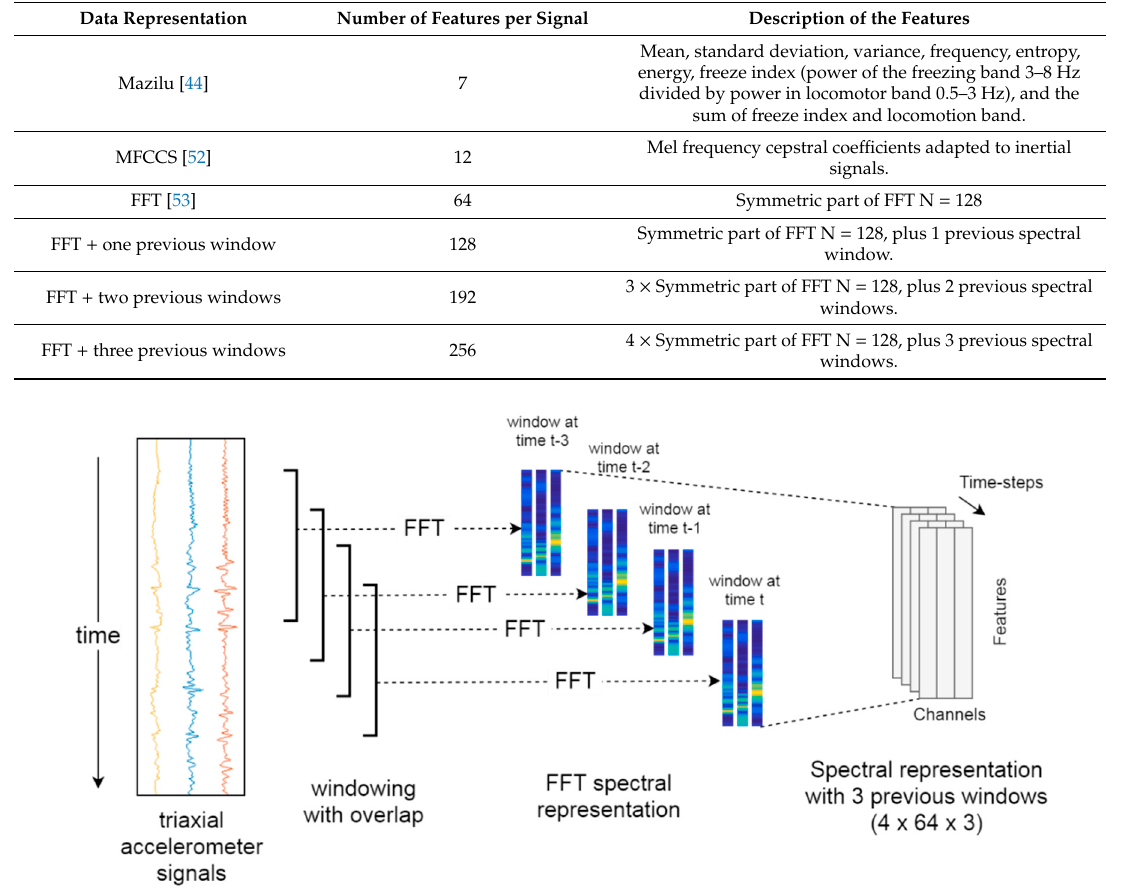
Figure 1. Fast Fourier transform (FFT) spectral representation with three previous windows.